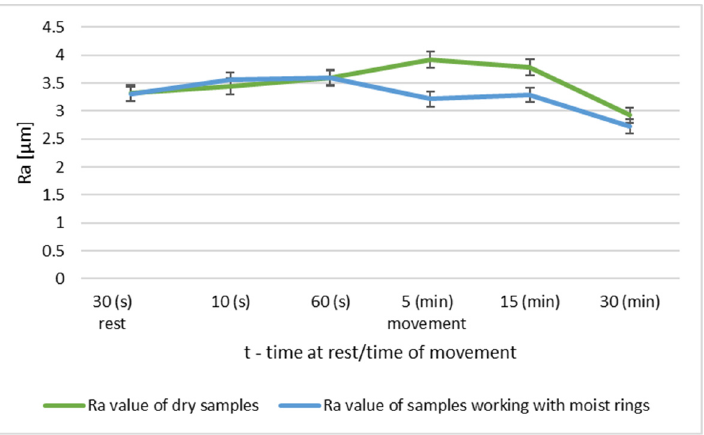
Figure 12. Comparison of Ra values of dry and wet ring samples for group III roughness.